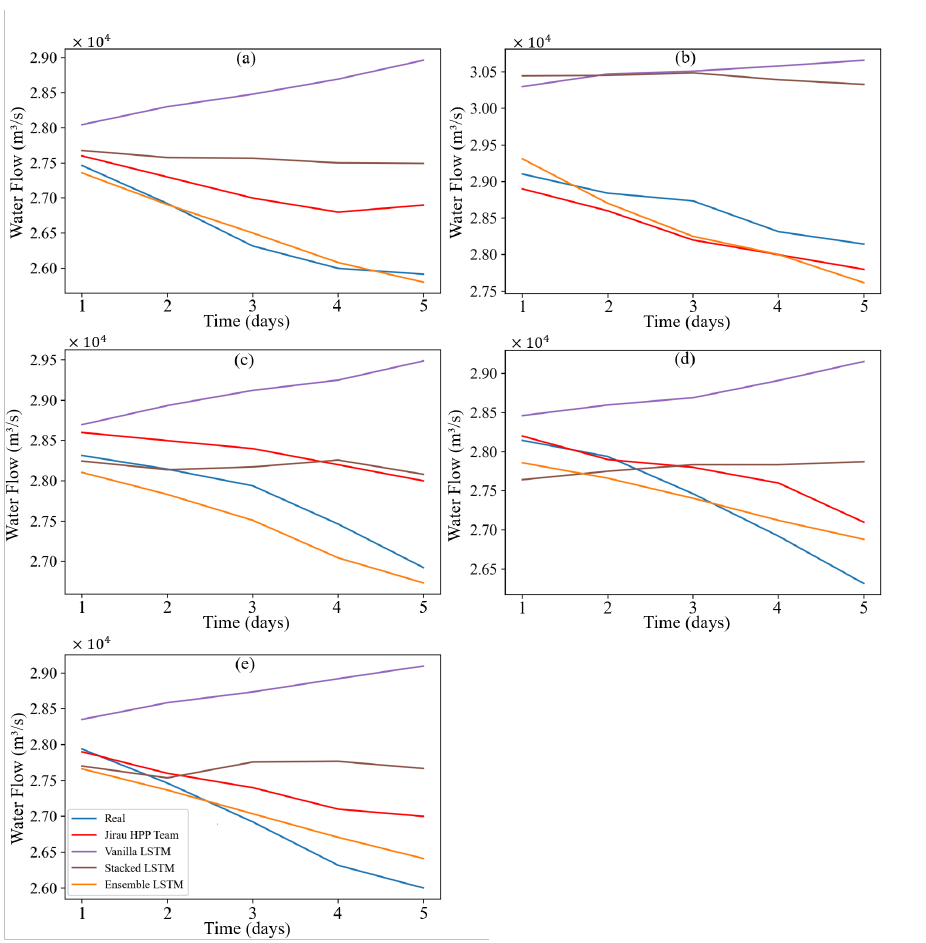
Figure 8. Forecasts of ( a ) scenario 1, ( b ) scenario 2, ( c ) scenario 3, ( d ) scenario 4 and ( e ) scenario 5, comparing the real value of the Madeira River streamflow, the forecasts of the Jirau HPP, Vanilla LSTM, Stacked LSTM, and proposed LSTM